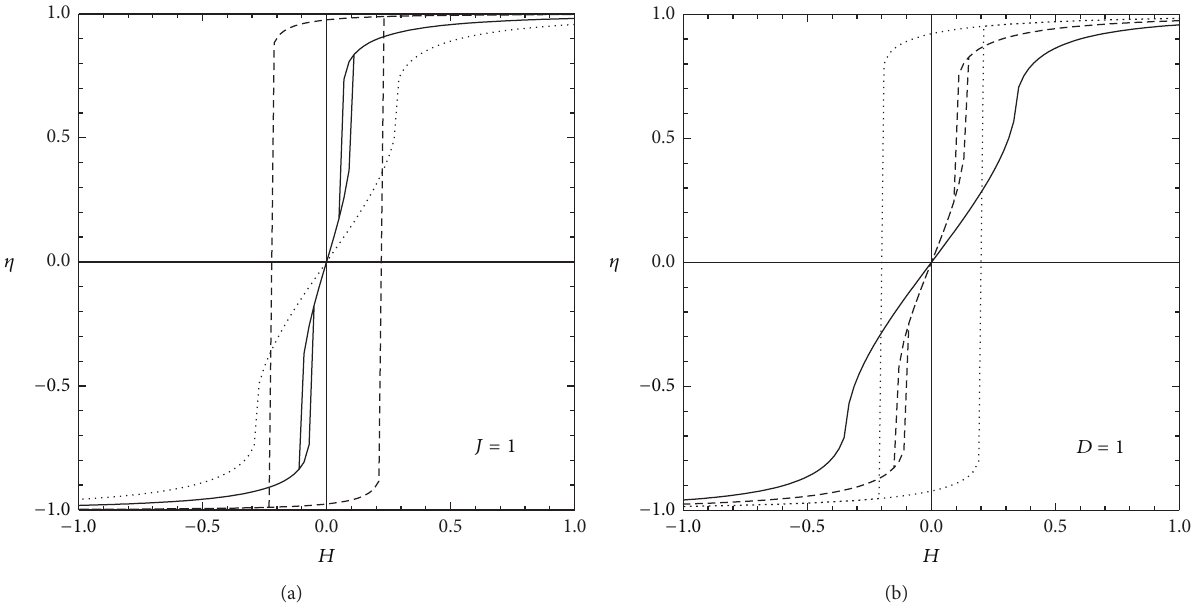
Figure 1: Mean field approximation. Dependence of 𝜂(𝐻) on external field 𝐻 through a complete hysteresis cycle. Either no hysteresis, single loop hysteresis, or double loop hysteresis is observed. (a) 𝐽 = 1 ; dashed line: 𝐷 = 0.3 , full line: 𝐷 = 0.8 , and dotted line: 𝐷 = 1.2 . (b) 𝐷 = 1 ; full line: 𝐽 = 0.5 , dashed line: 𝐽 = 1.2 , and dotted line: 𝐽 = 2